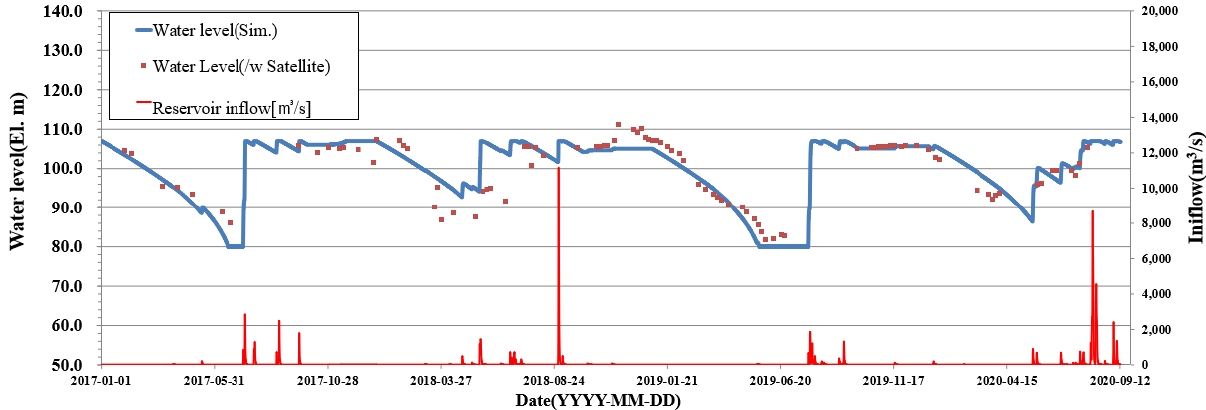
Figure 10. The time series of cumulative monthly areal rainfall in the Imjin River basin.